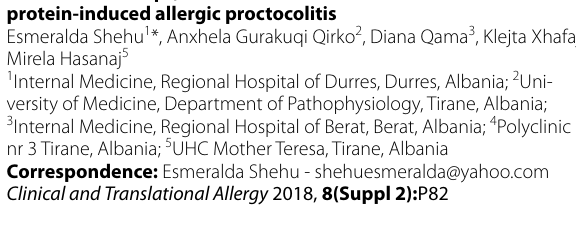
Table 1 Description of the adverse events (AEs)